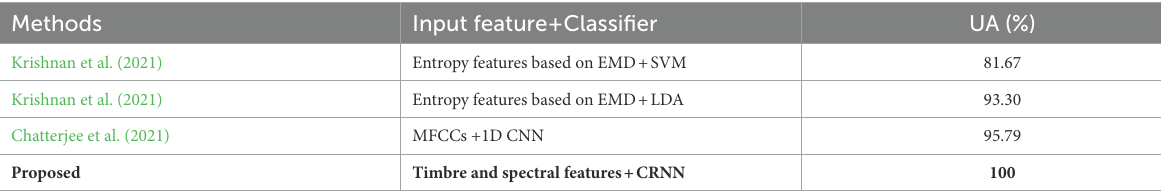
TABLE 5 Comparison of different SER methods on the TESS